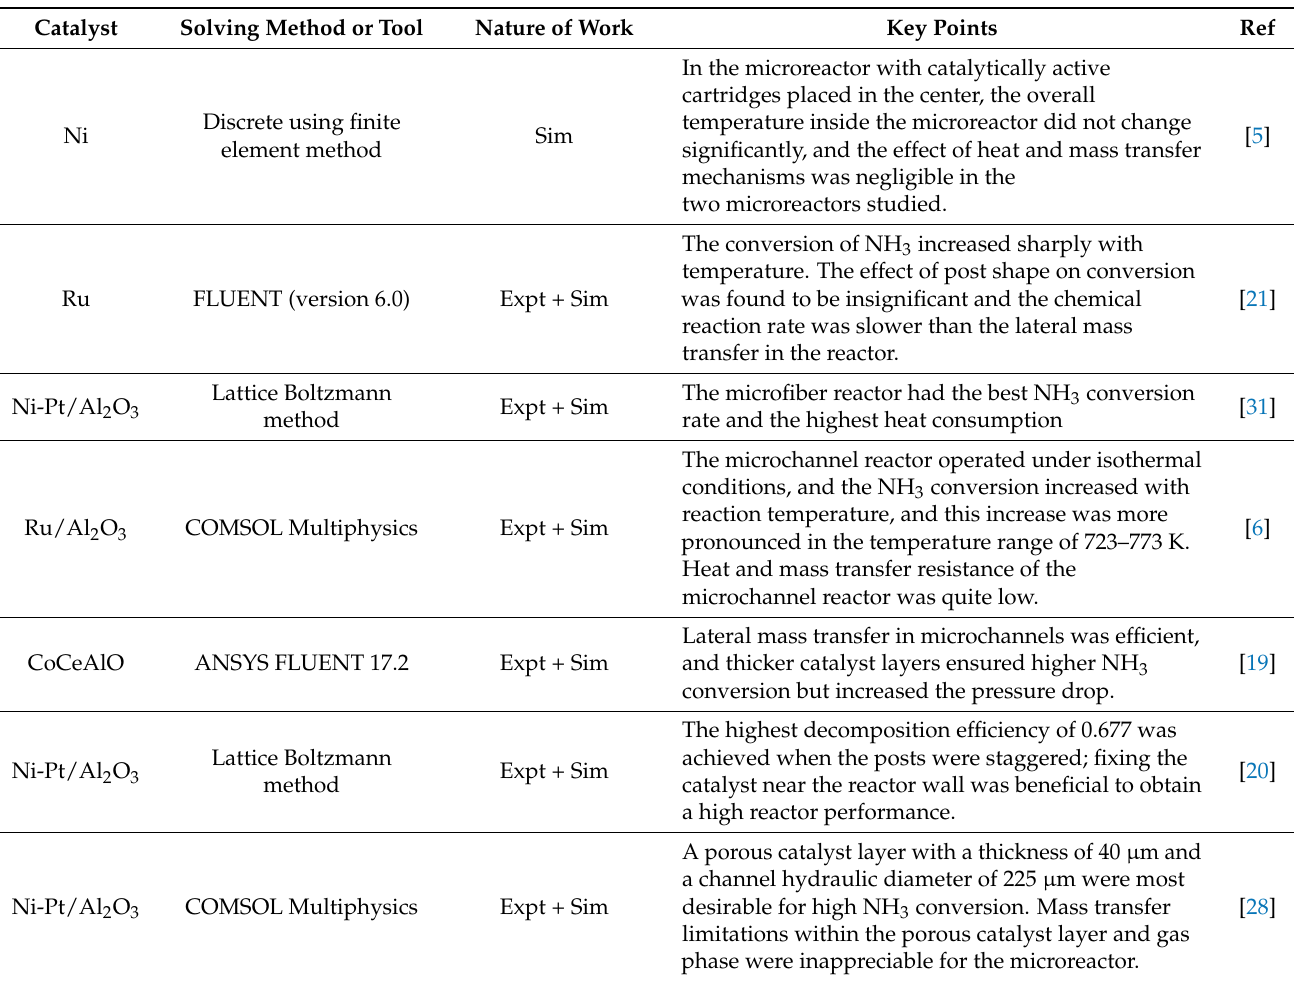
Table 2. Summary of numerical simulation of NH 3 decomposition in